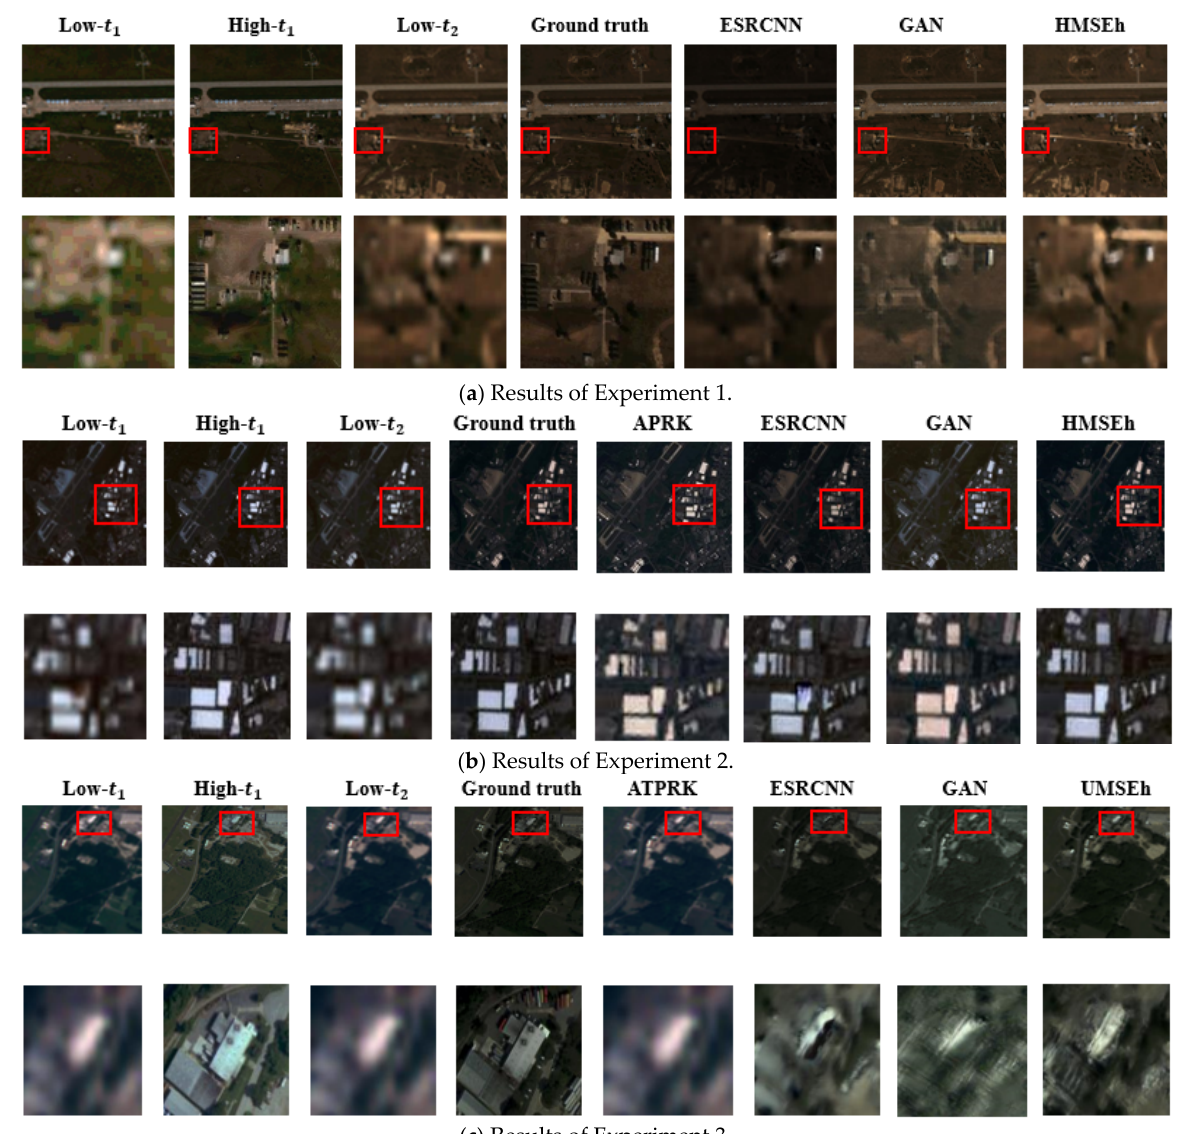
Images generated by the HRNet-backbone model (HMSEh) are the sharpest by visual in- spection.